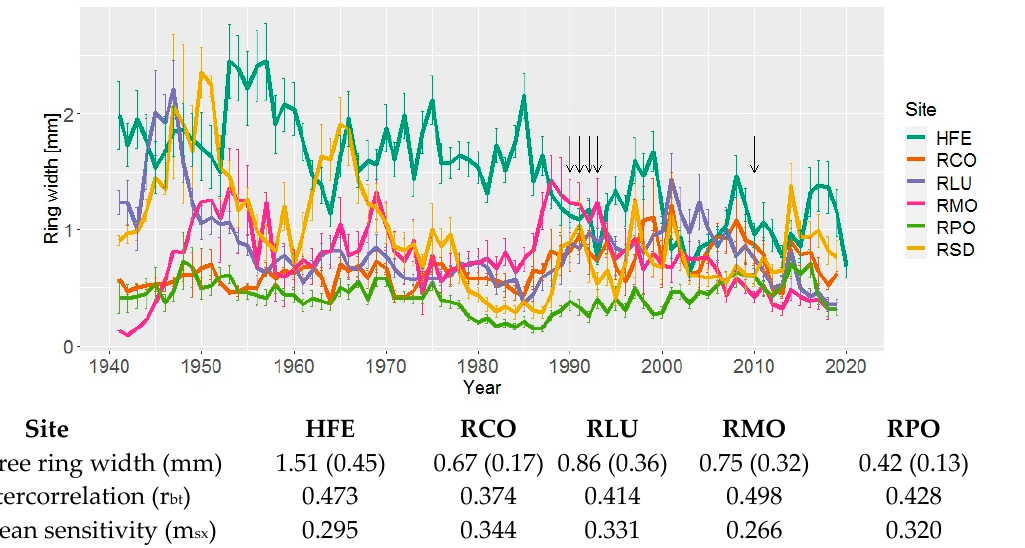
Figure 3. Raw ring width chronologies in the common interval of the sites in the period 1940–2020. Lines indicate mean ring widths of all individuals sampled in the sites, vertical bars indicate the standard errors, together with their values indicated in the table below, and completed with the series intercorrelation values (r bt ) and the average mean sensibility values (m sx ). Site abbreviations: Suhardul Mic (RCO), Tinovul Luci (RLU), B ă ile Tusnad (RMO), Poiana Stampei (RPO), Saru Dornei (RSD), Feny ő f ő (HFE). Annual rings selected for wood anatomical analyses are indicated by arrows.